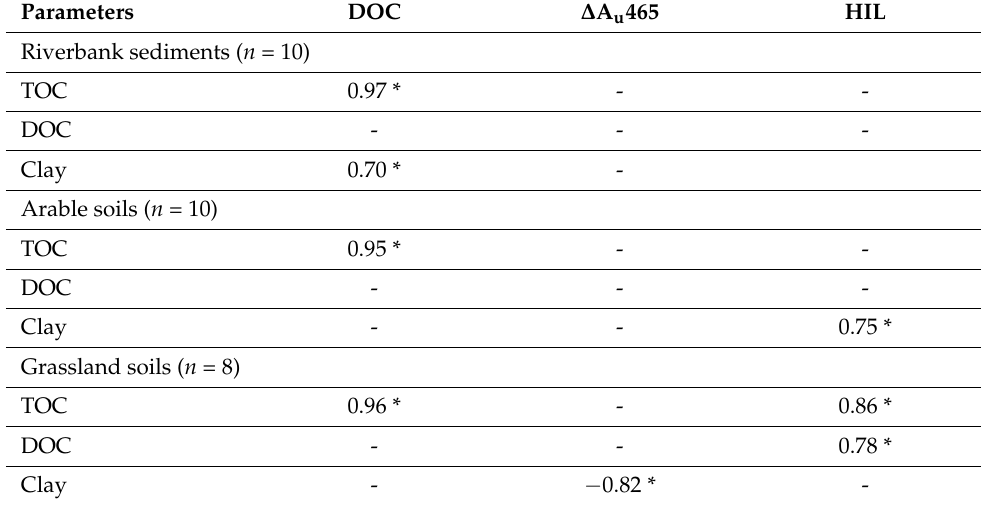
Table 3. Pearson linear correlation coefficient values, p < 0.05, in riverbank sediments ( n = 10).